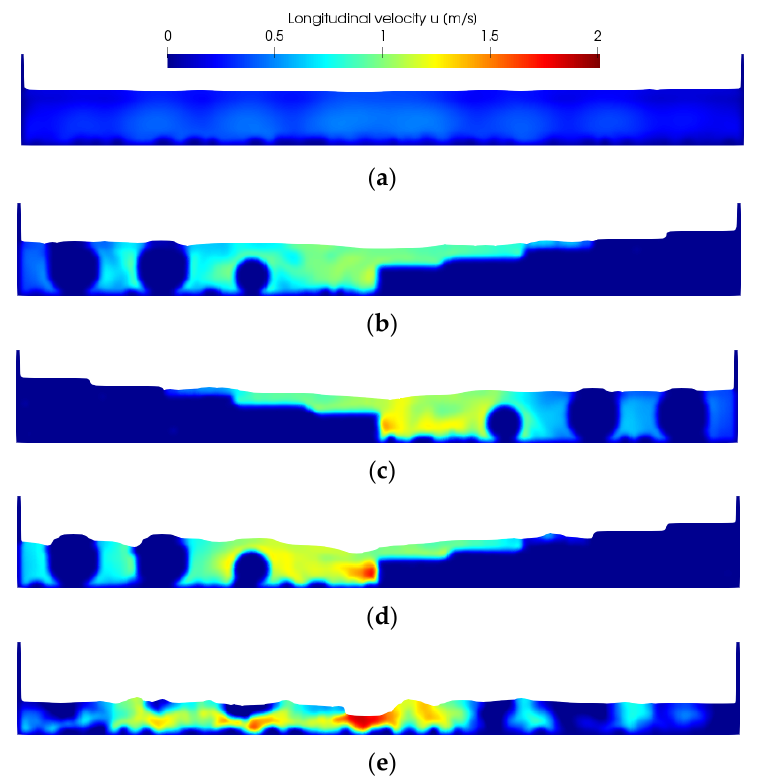
Figure 12. Longitudinal velocity u for the Q 2 case, looking in the downstream direction, at cross- sections. ( a ) x = 1.5 m (i.e., upstream of the first row of obstacles), ( b ) x = 3 m (i.e., first line of cylinders), ( c ) x = 6 m (i.e., second line of cylinders), ( d ) x = 9 m (i.e., third line of cylinders), and ( e ) x = 11 m (i.e., downstream of the last line of obstacles).